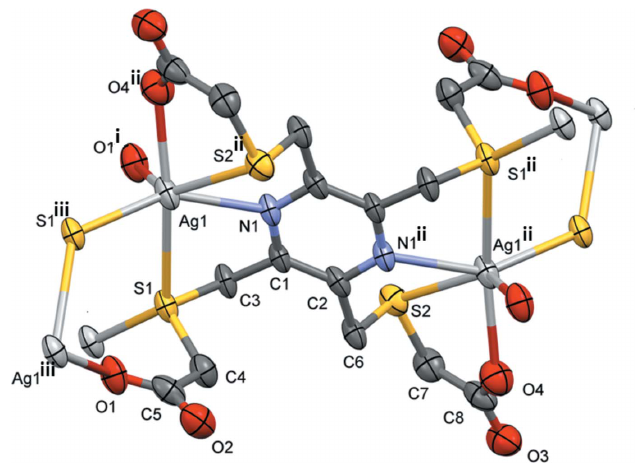
Figure 1 The molecular structure of the silver complex dianion of compound I , with atom labelling. Displacement ellipsoids are drawn at the 50% probability level. For clarity, the potassium cation and the disordered water molecules have been omitted. [Symmetry codes: (i) (cid:4) x , y + 1 (ii) (cid:4) x , (cid:4) y + 1, (cid:4) z + 1; (iii) (cid:4) x , y (cid:4) 1